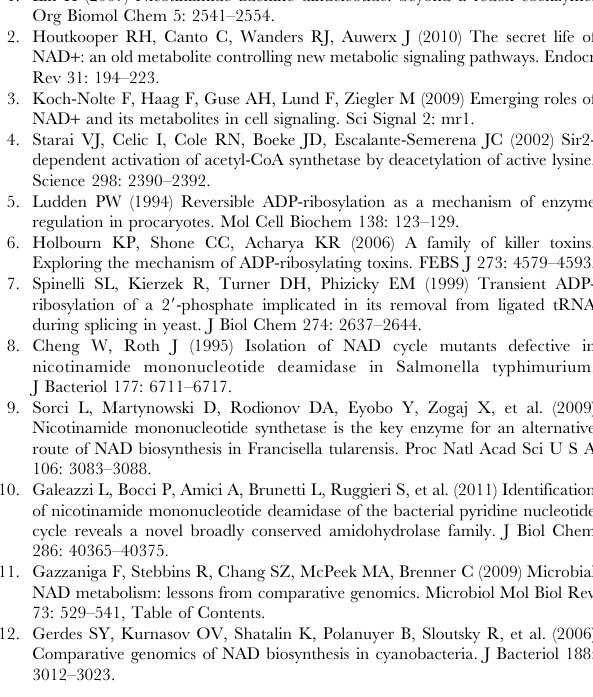
Table S1 Sequences of oligonucleotides used as primers for cloning and